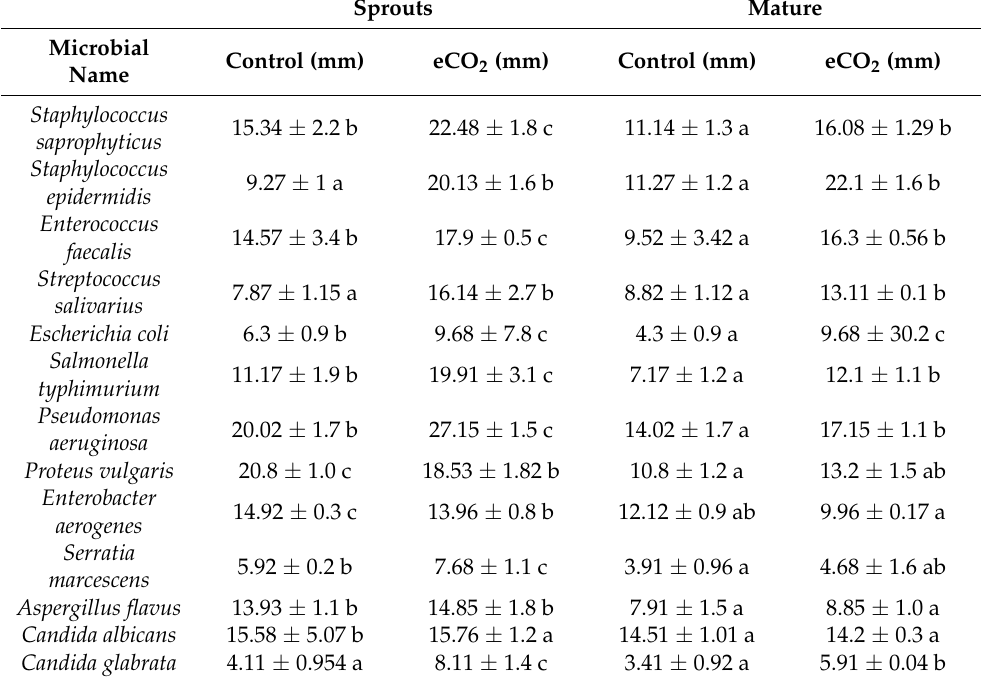
Table 2. Antimicrobial activity of control and eCO 2 -treated caraway sprouts and mature plants. The activity is presented as the diameter of inhibition zone (mm). Data are represented by the means of at least 3 replicates ± standard deviations. Different small letter (a, b, c) within a row indicate significant differences between control and eCO 2 -samples. One-way analysis of variance (ANOVA) was performed. Tukey’s test was used as the post-hoc test for the separation of means ( p < 0.05). Sprouts Mature